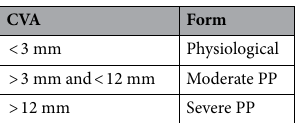
Table 1. Classification of PP using CVA (at 30°).